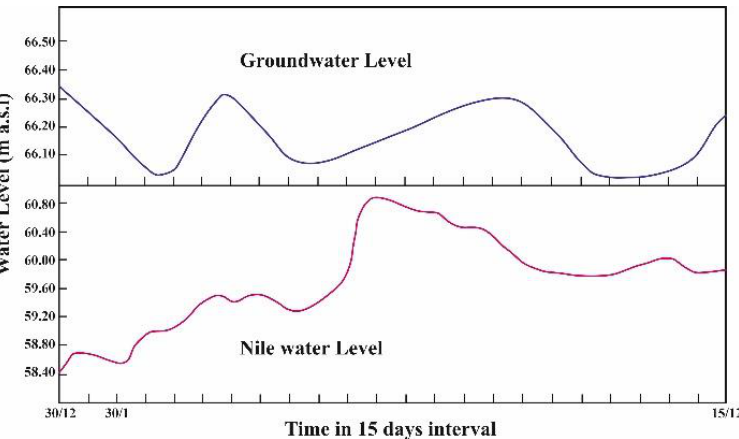
Figure 6. Hydrograph of the Nile River at El-Balyana and the groundwater levels in the Roman well [58].